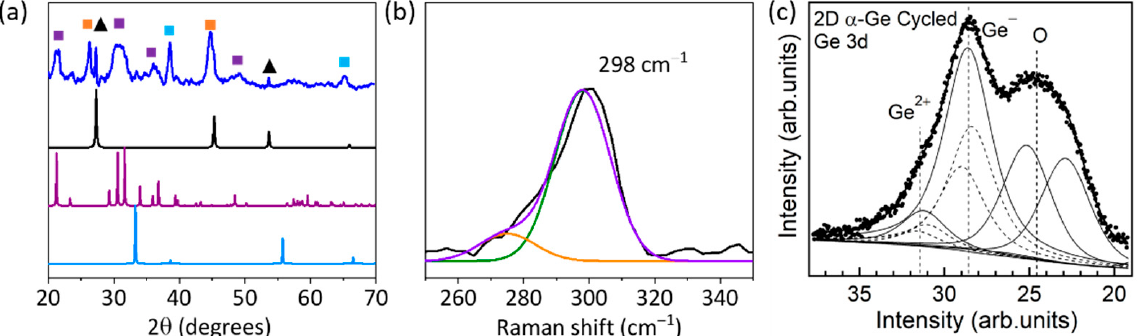
Figure 5. ( a ) PXRD pattern of 2D α -Ge anodes after the cycling process (blue line), simulated Li 2 CO 3 (purple line), and simulated Li 2 O (blue line). Black triangles are assigned to Ge-crystalline, purple squares are assigned to Li 2 CO 3 , blue squares are assigned to Li 2 O, orange squares are assigned to VGCF, and green squares are assigned to Cu. ( b ) Raman spectrum of 2D α -Ge after the cycling process. Raman spectrum measurement (black line), deconvoluted contributions of crystalline α -Ge at 298 cm − 1 (green line), amorphous Ge at 275 cm − 1 (orange line), and cumulative plot of both contributions (purple), laser power of 1.75 mW. ( c ) Ge 3d and O 2s XPS peaks (h ν = 1253.6 eV) for 2D α -Ge anode after the cycling process. Experimental data (dotted line) and resulting fit (thick continuous lines). Thin lines correspond to the different contributions and dashed lines to the spin-orbit splitting of Ge 3d.